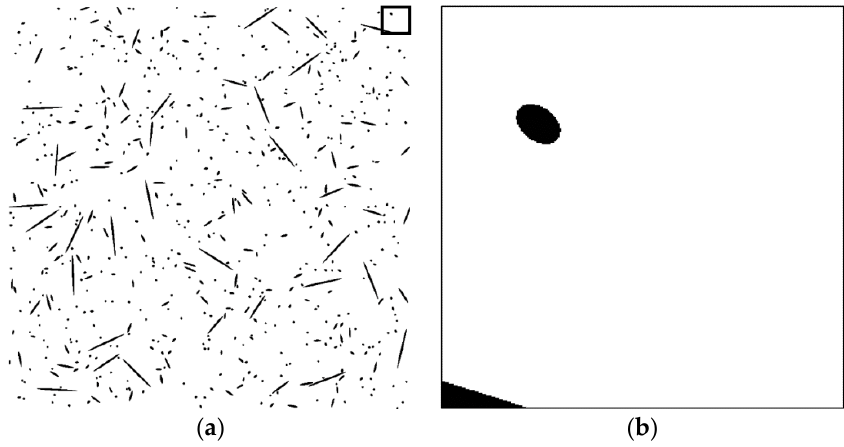
Figure 9. Artificial fiber images with a diameter of 25 pixels in a two ‐ dimensional random distribution in the area of 5000 pixels by 5000 pixels (I25 ‐ 2): ( a ) section image and ( b ) magnified image.